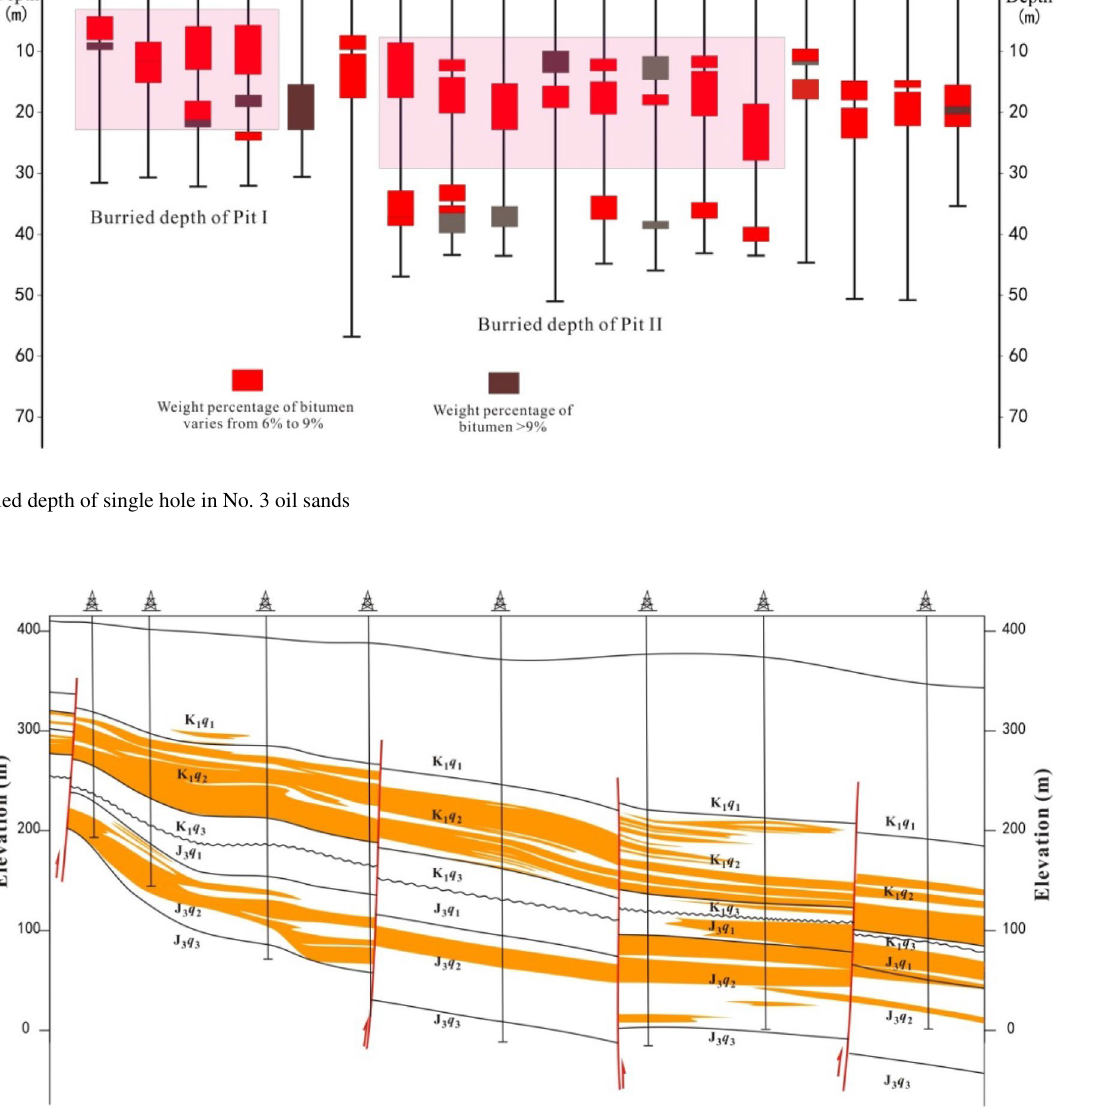
Fig. 10 Pay sand profile map in No. 1 oil sands